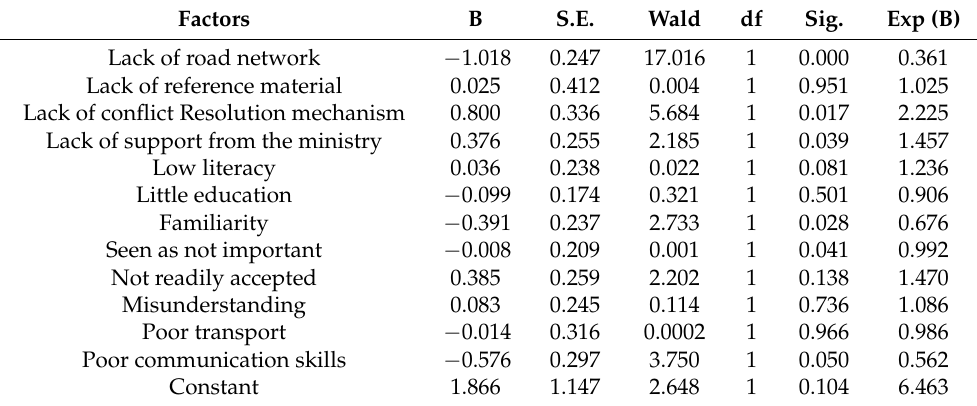
Table 3. Factors associated performance of community health